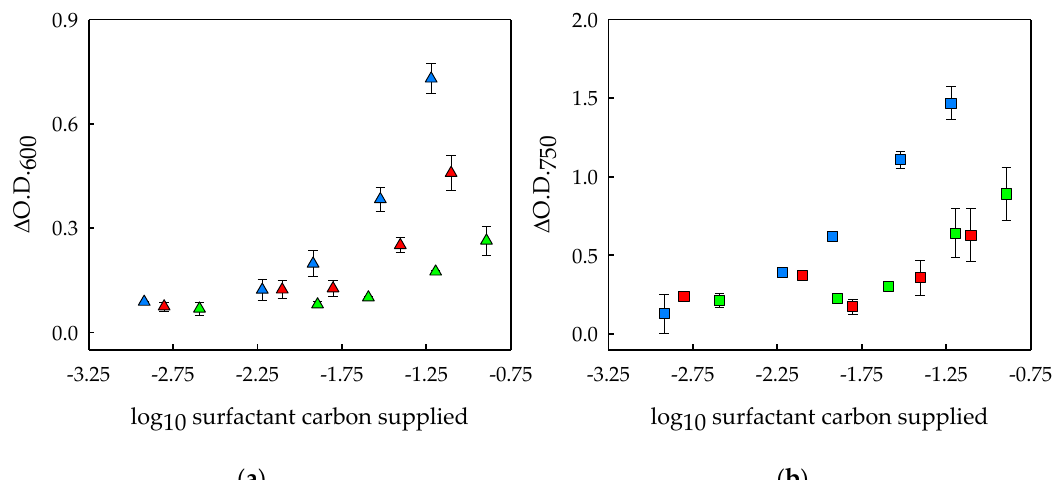
Figure 2. Microbial growth in cultures with the addition of BSA (blue symbols), Saponin (red symbols) or Tween 20 (green symbols). ( a ) Bacterial growth expressed as the increment in optical density at 600 nm after 2.8 days of cultivation ( ∆ O.D. 600 ) in the supernatant of Scenedesmus obliquus cultures enriched with BSA, Saponin and Tween 20 at concentrations of 1, 5, 10, 25 and 50 CMC; ( b ) Scenedesmus obliquus growth expressed as the increment in optical density at 750 nm after 2.8 days of cultivation ( ∆ O.D. 750 ) in cultures enriched with BSA, Saponin and Tween 20 at concentrations of 1, 5, 10, 25 and 50 CMC. Surfactant concentration is expressed as the carbon dosage resulting from surfactant addition (logarithmic values, in milligrams). The average values of duplicate cultures are shown, together with their corresponding standard